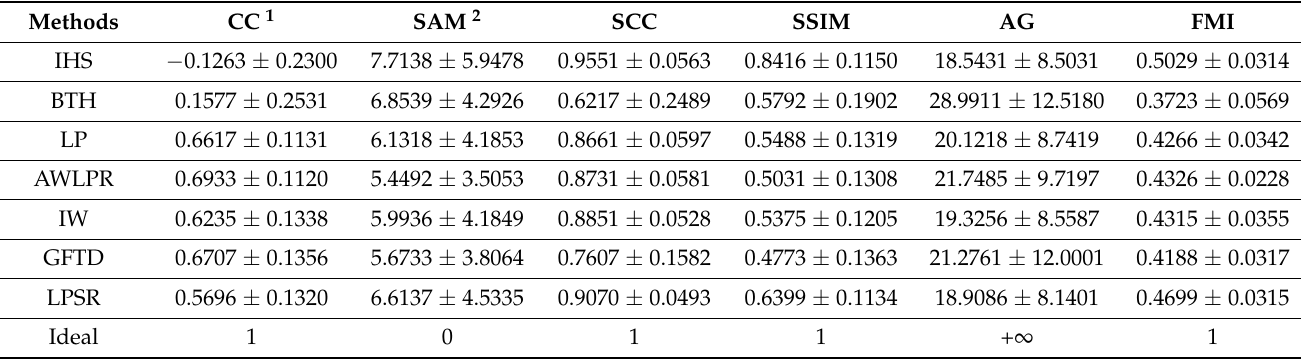
Figure 7. Bar chart of the comprehensive index. Table 4. Quantitative analysis on a large set of images.